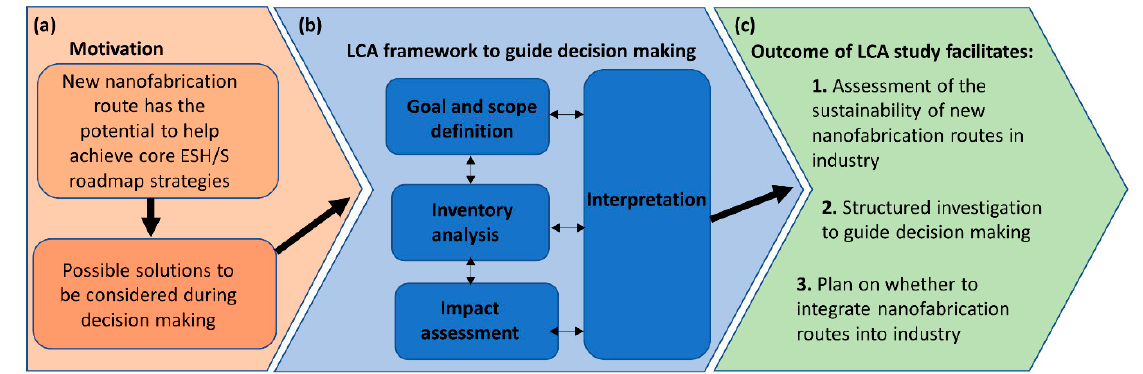
Figure 10. Objectives and phases of polymer brush and BCP lithography LCA. The arrows indicate the progression from part ( a ) initial Motivation to ( b ) building a LCA framework to guide decision making to part ( c ) the outcome of the LCA study. In part ( b ) the four stages of the LCA are outlined as defined by the International Organization for Standardization (ISO) 14000 standards — specifically, 14040 and 14044 [237,250].